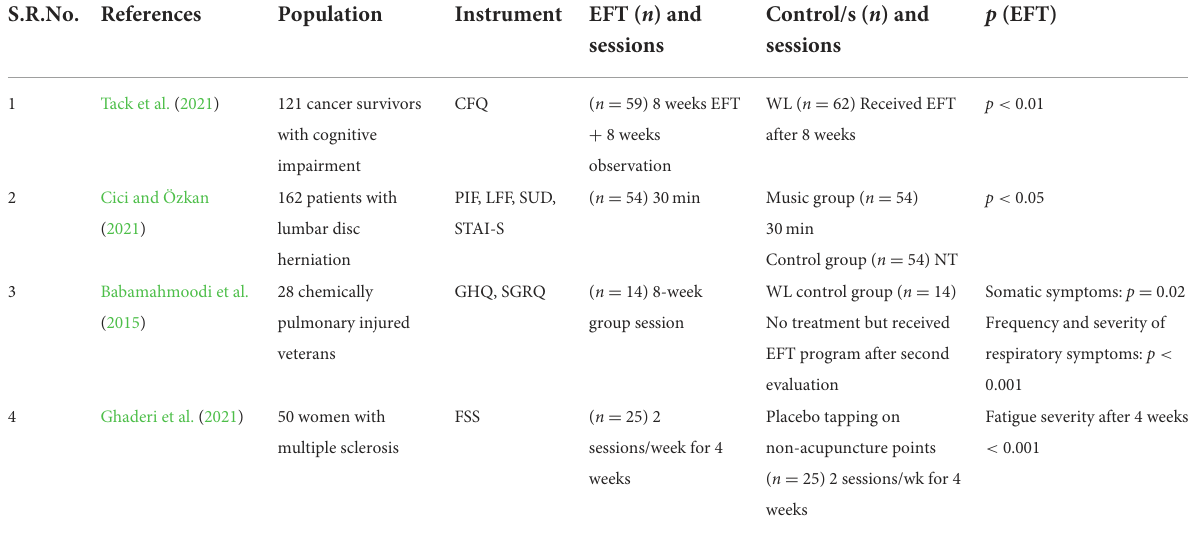
TABLE 10 RCTs of EFT studies on somatic symptoms not included in the Stapleton et al. (2021)